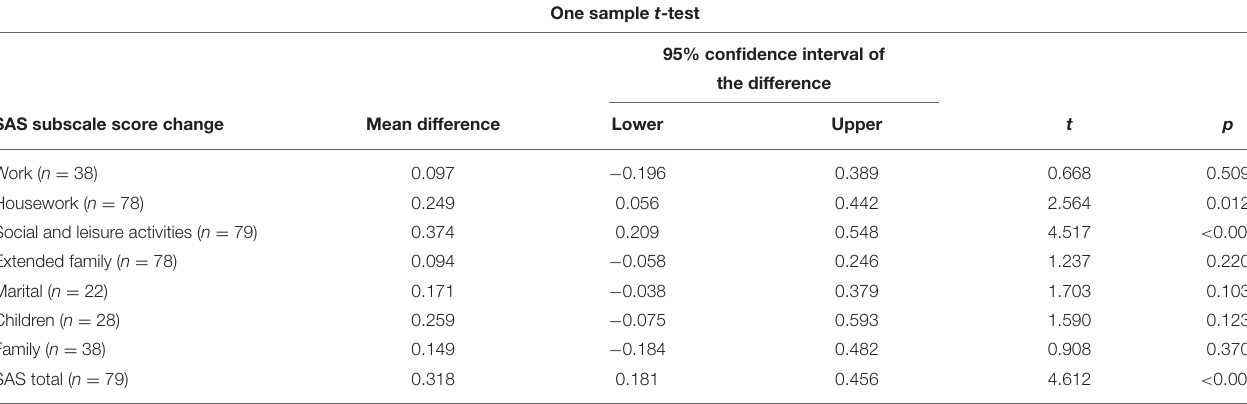
TABLE 4 | SAS subscale score change from baseline for IPSRT.